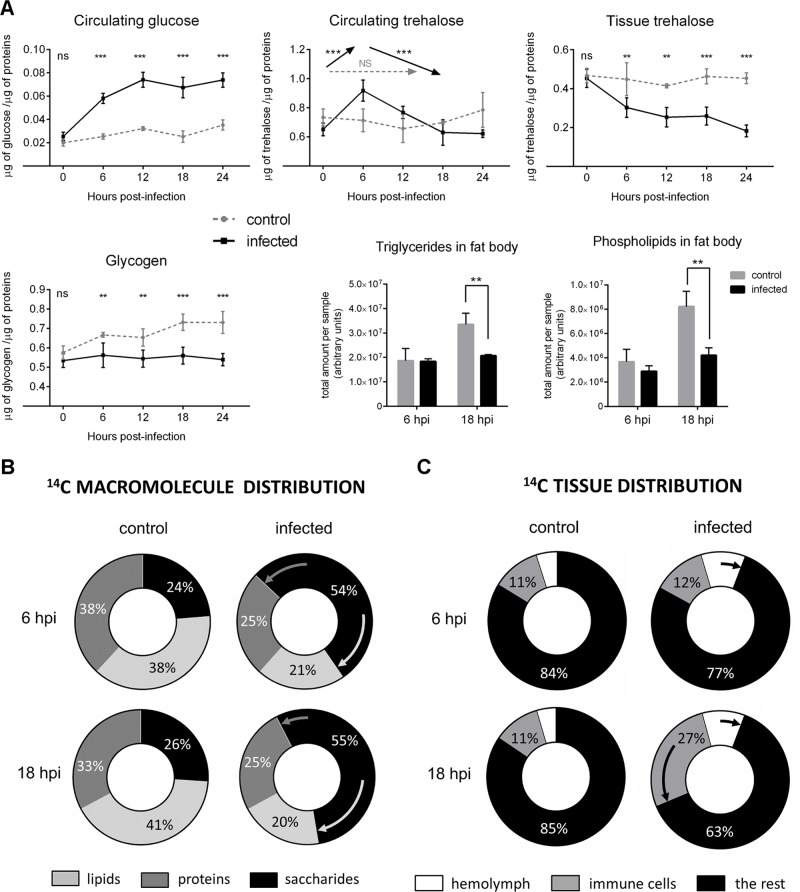
Metabolic changes during immune response in w flies.(A) Nutrient contents in the hemolymph, whole larval lysates, and fat body at different time points after infection (uninfected control: grey dashed line and grey column; infected: solid black line and column). Circulating glucose increases, tissue trehalose decreases, glycogen and lipids accumulation ceases upon infection; circulating trehalose first increases and then decreases making a 6 hpi peak. Values are mean ± SEM of four experiments (three for lipids). Asterisks show statistical significance (*p < 0.05; ** p < 0.005; *** p < 0.0005; ns, not significant) when compared between infected and control samples at indicated time points; arrows (Circulating trehalose, middle) indicate increase, decrease, and no change (NS), respectively, between time points. Significance of differences was tested by two-way ANOVA. (B) Percent incorporation of 14C-labeled dietary glucose into lipids, proteins, and saccharides in whole larvae. Incorporation into lipids and proteins decreases upon infection, enlarging saccharide fraction as indicated by arrows. (C) Percent distribution of 14C into the hemolymph, immune cells (circulating hemocytes, and lymph gland) and the rest of the larvae (brain, imaginal discs, gut, fat body, and carcass). 14C first increases in hemolymph at 6 hpi (from 5% to 10%) and then also in immune cells (from 11% to 27%) at the expense of the rest of the organism upon infection; arrows indicate infection-induced changes. This figure shows data for the w genotype; the same values are shown in subsequent figures when compared with other genotypes. See S2 Fig for statistical analysis.